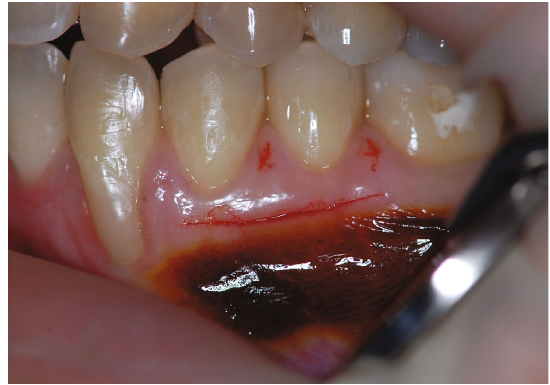
Figure 4: The MARF technique was used to increase the donor area. Initially, a horizontal incision was made onto the attached portion of the gingiva.